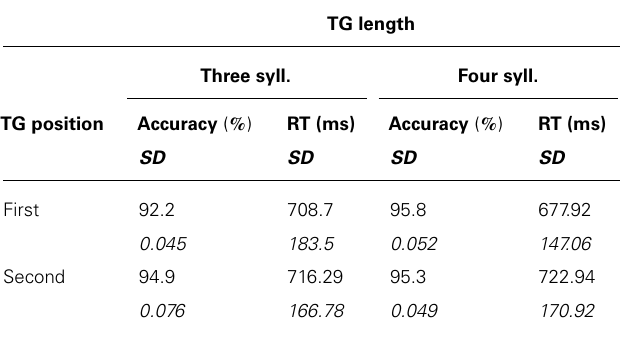
Table 1 | Behavioral results: means and standard deviations of correct recognition scores and RT as a function ofTG length and position. TG length Three